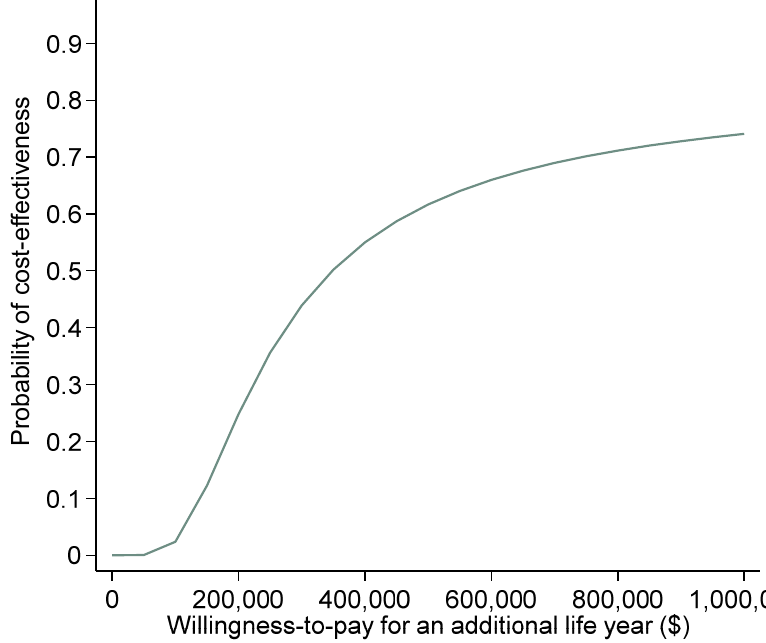
Figure 2. The cost-effectiveness acceptability curve (CEAC).